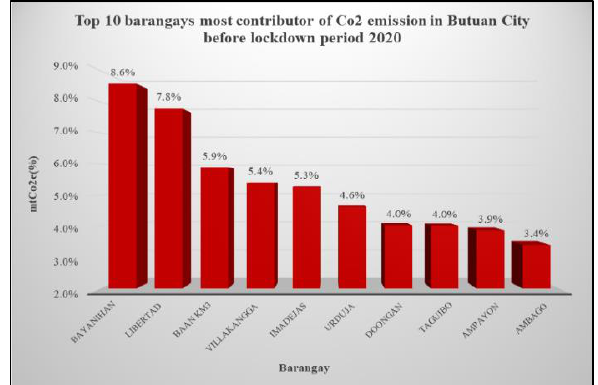
Figure 6. Top 10 most contributor of Carbon dioxide emission in Butuan City during COVID-19 Pre- lockdown Period.